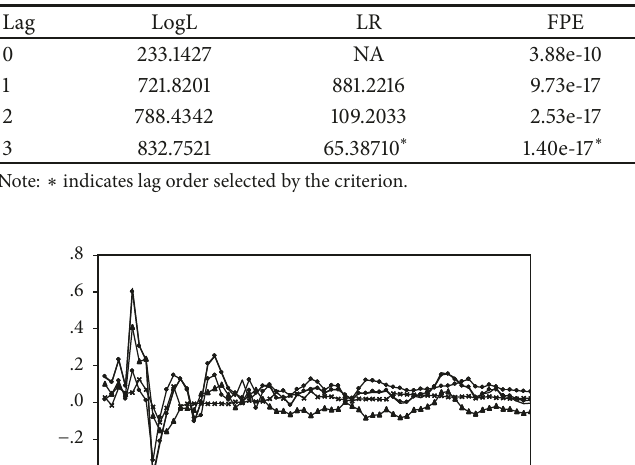
Table 3: Optimal lag orders of VAR (vector autoregression) model.